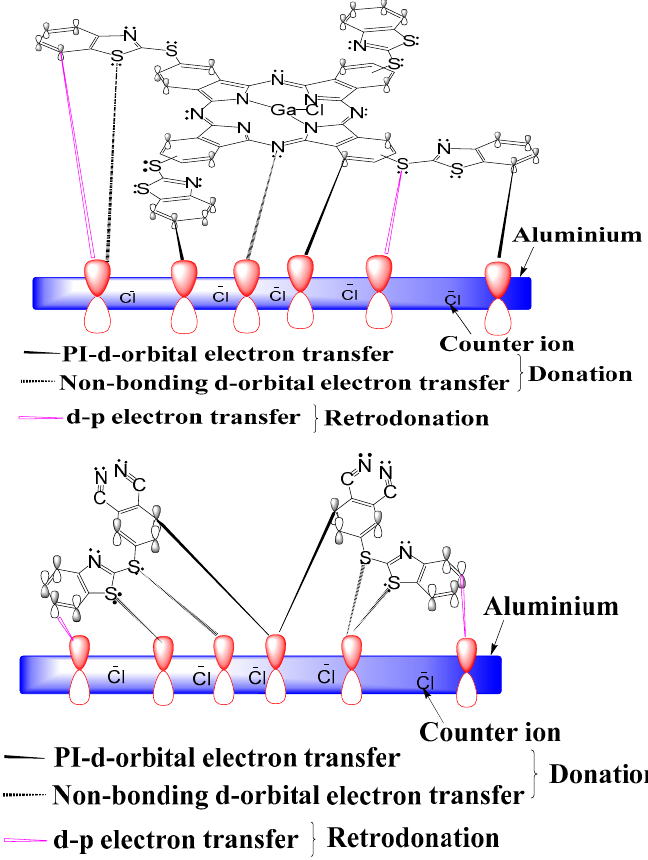
Figure 11. Proposed mechanism of adsorption of studied inhibitors on aluminum in hydrochloric acid solution.